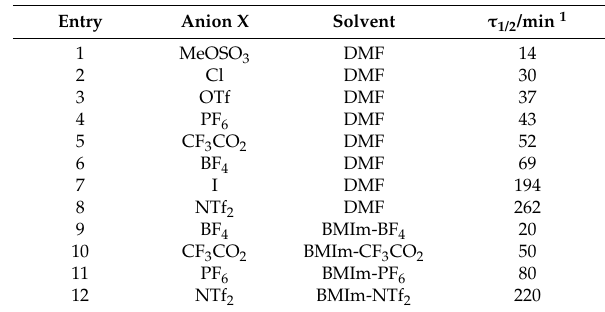
Table 2. Stability of 1-butyl-3-methyl-2-ylidene. Effect of the counterion on NHC half-life time τ 1/2 . Reproduced with permission from [40]. Copyright Elsevier, 2016.